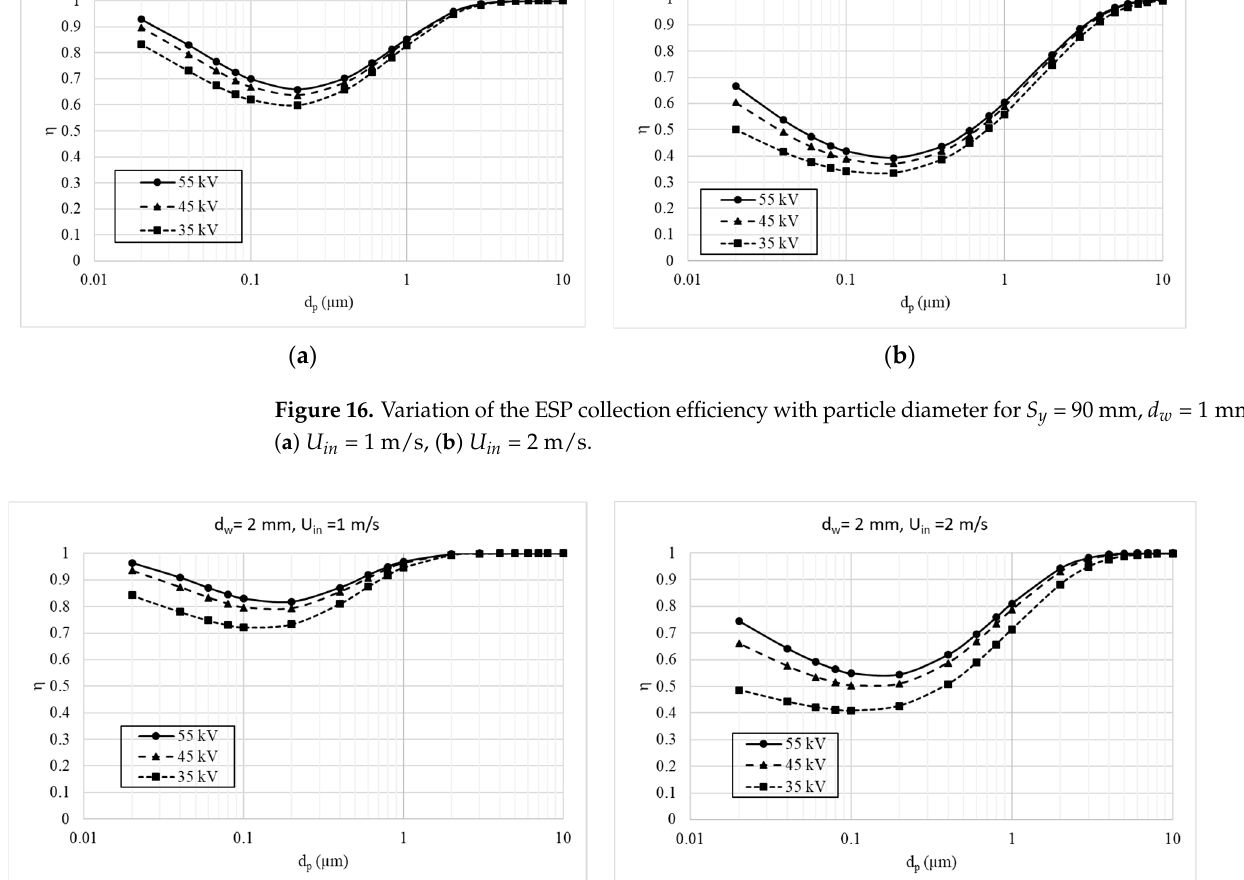
Figure 15. Variation of the ESP collection efficiency with particle diameter for S y = 90 mm, d w = 0.3